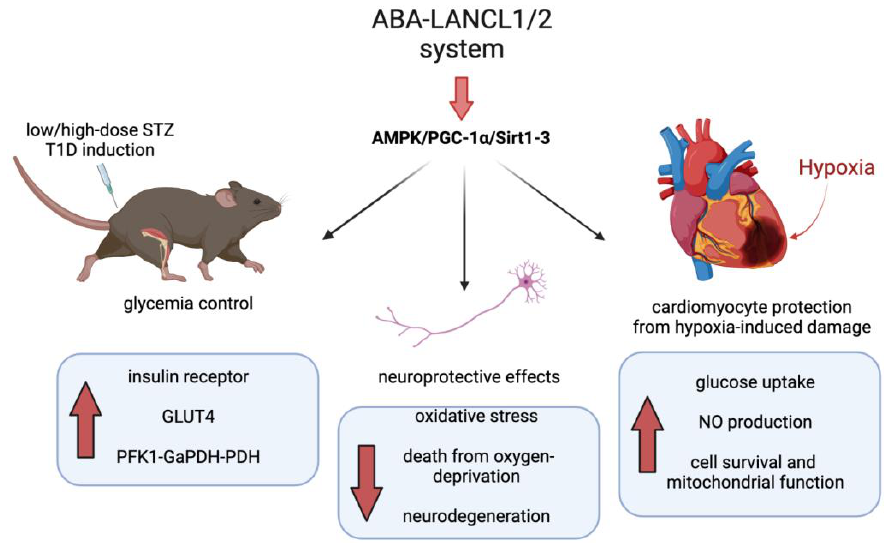
Figure 3. The ABA/LANCL system activates the AMPK/PGC-1 α /Sirt1-3 axis. By activating the AMPK/PGC-1 α /Sirt1-3 axis in myocytes and neuronal cells, the ABA/LANCL system impacts the fundamental physiological functions related to cell glucose uptake and metabolism, mitochondrial biogenesis and function, and protection from oxidative stress. These functions are all called upon to reduce the systemic effects of diabetes. Red arrows indicate increase (right and left panel) or de- crease (central panel) of the indicated effects.